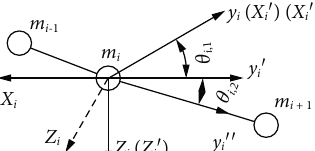
Figure 2: Rigid link ’ s vector and tow point